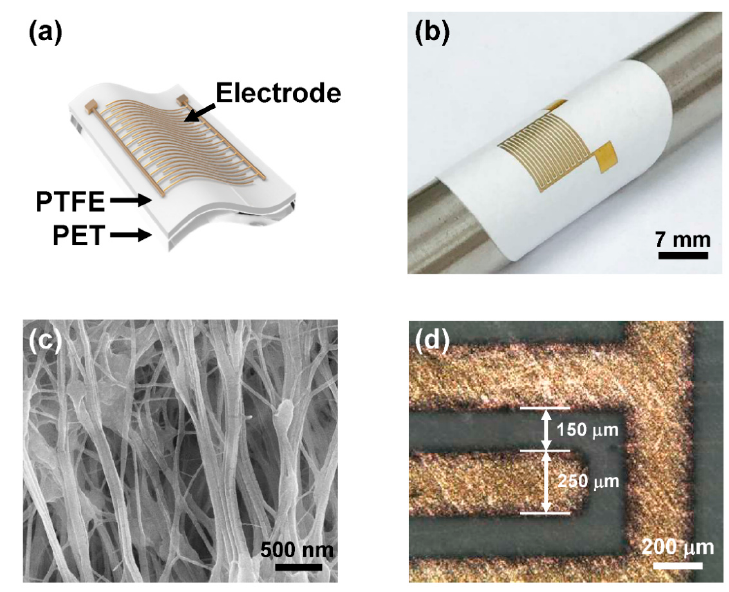
Figure 1. ( a ) 3D schematic structure and ( b ) photograph of a flexible H-PTFE humidity sensor; ( c ) FE-SEM image of the H-PTFE membrane; ( d ) Optical microscope image of the interdigitated electrode.